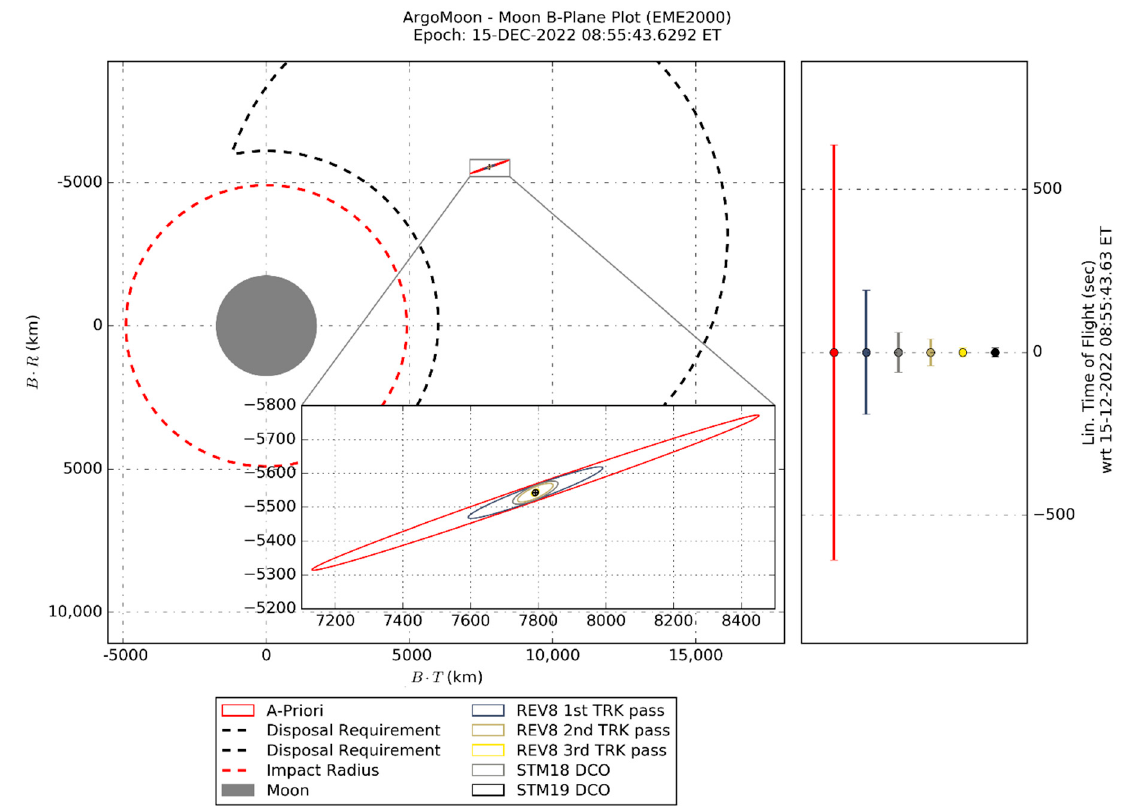
Figure 13. B-Plane uncertainties (3-sigma) for the fly-by M3 with DCO at the end of each tracking (TRK) pass up to the DCO of the STM19 (last maneuver before the fly-by). “ A-priori ” refers to the results obtained propagating the expected ephemeris uncertainty at the end of the previous arc (REV7).